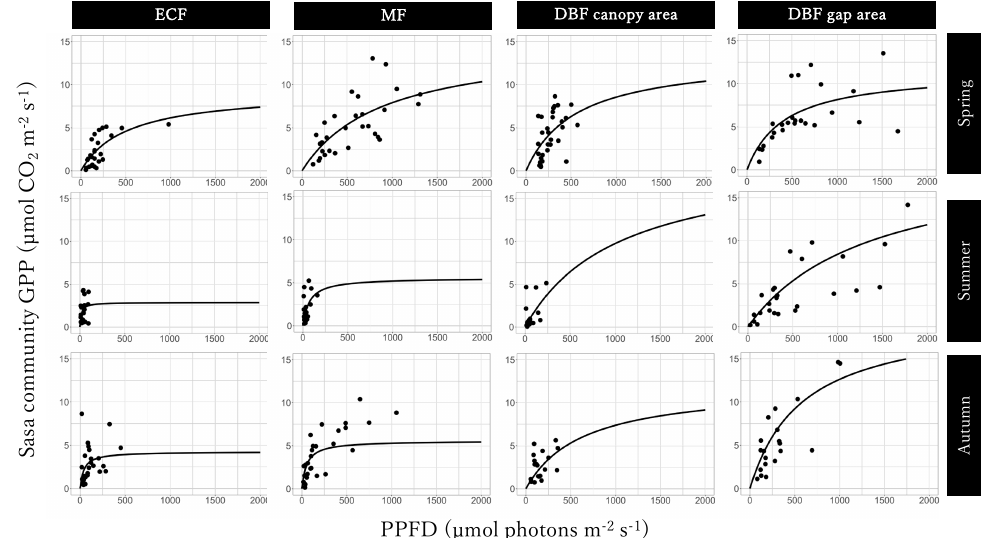
Figure 5. Light- Sasa community GPP curve in the evergreen coniferous forest (ECF), mixed forest (MF), deciduous broadleaved forest (DBF) canopy area, and DBF gap area in each season. Table 1. Parameters of the light- Sasa community GPP curve in the four sites.